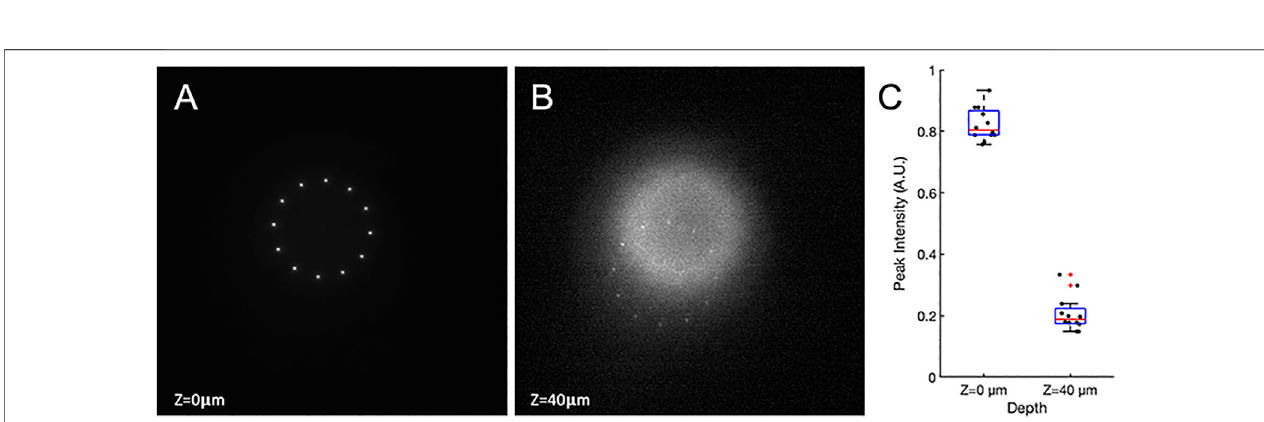
FIGURE 6 | Two photon images of fi rst and second order diffracted light. A thin fl uorescent sample is used, sitting at the object plane of both the bottom and top objectives. (A) The fi rst order of diffraction forms at the object plane. (B) The top objective is moved axially away from the sample by 40 μ m where the second order pattern is formed. (C) The distribution of peak intensity at each